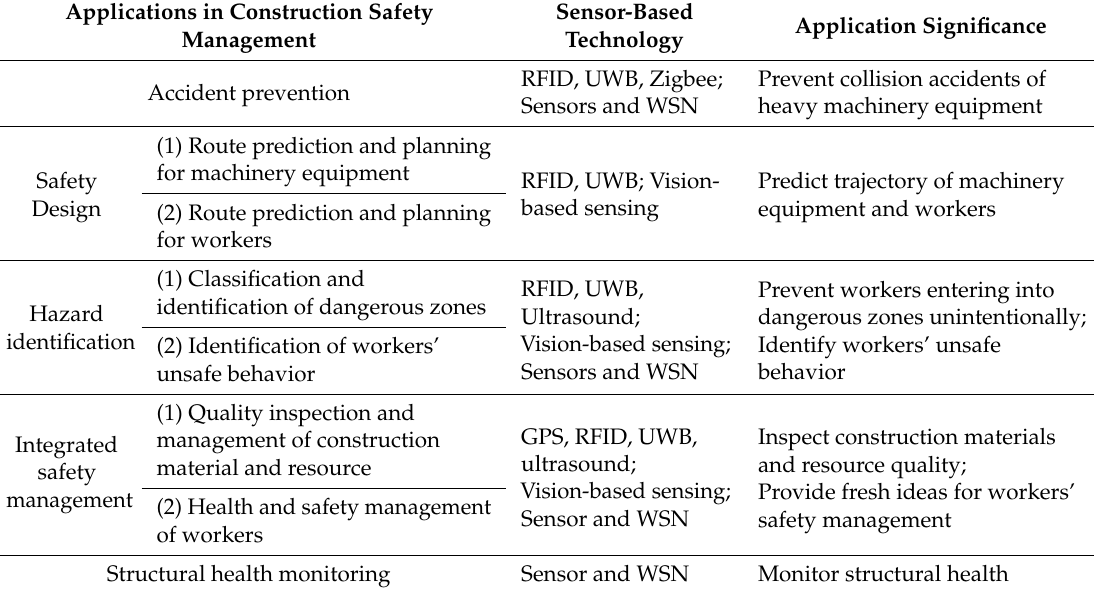
Figure 6. The relationship between sensor-based technology’s application range and construction safety management. Table 4. Main applications of sensor-based technology in construction safety management.